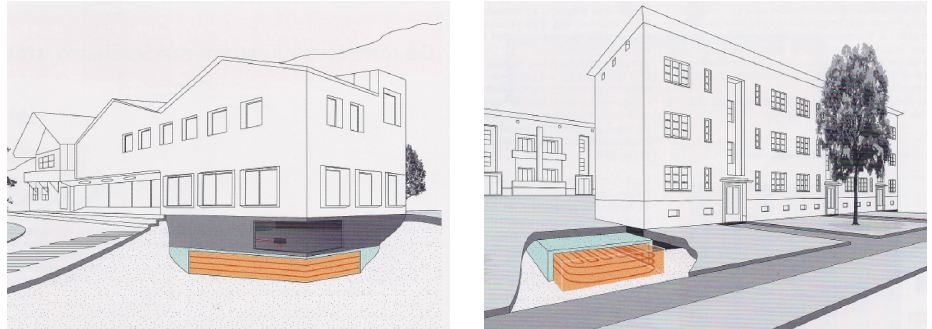
Figure 1. Real-world GES: under the new building ( left ) and during the renovation beside the building ( right ). Source: http://geo-ec.de/erdwaermetank/ (website access date: 25 May